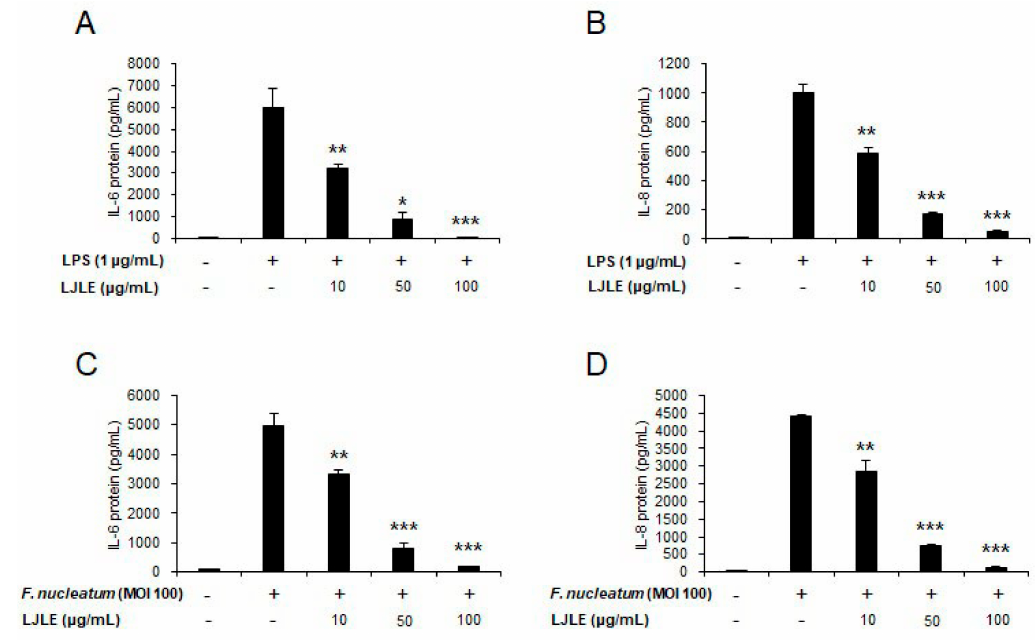
Figure 6. Pretreatment with LJLE inhibits pro-inflammatory cytokine secretion in LPS- or F. nucleatum -infected human PDLFs in a concentration-dependent manner. Human PDLFs were pretreated for 2 h with 0, 10, 50, or 100 μ g/mL LJLE, followed by stimulation with E. coli LPS or F. nucleatum (MOI 100) for 24 h, and supernatants were analyzed using enzyme-linked immunosorbent assay (ELISA) to detect the presence of IL-6 and IL-8. Concentration-dependent inhibitory effect of LJLE pretreatment on IL-6 and IL-8 protein expression in ( A , B ) E. coli LPS-stimulated and ( C , D ) F. nucleatum -infected PDLFs. * p < 0.05, ** p < 0.01, and *** p < 0.001 compared with LPS or F. nucleatum alone (unpaired two-tailed Student’s t -test).